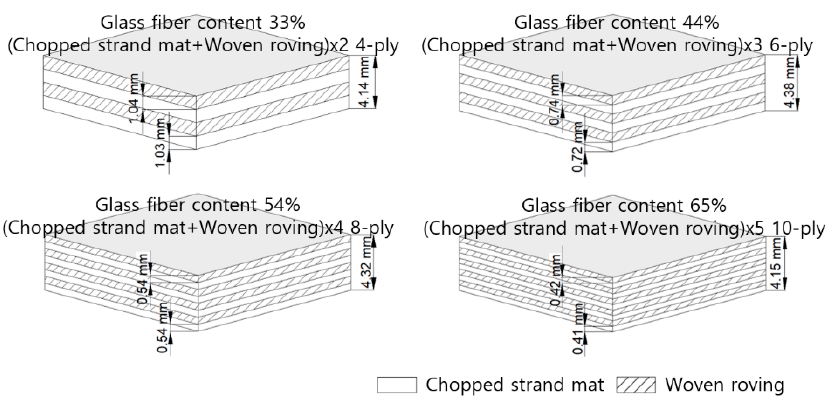
Figure 3. Designs of single-material specimens produced using chopped strand mat. Table 1. Design details of single-material specimens.